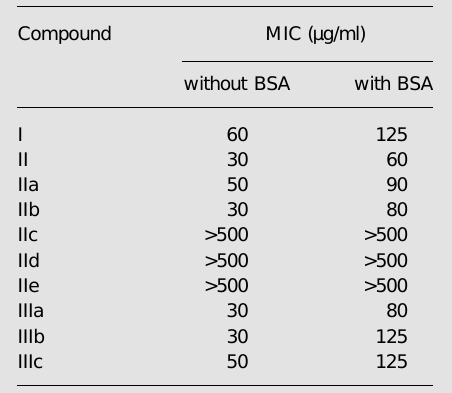
Figure 2. Dose-response effect of 5-amino-8-hydroxy-1,4-naphtho- quinone (compound II) against Staphylococcus aureus (circles), S. epidermidis (squares), and S. intermedius (triangles). The mi- croorganism suspension con- taining 10 6 CFU/ml was added to sterile tubes containing com- pound II to obtain the indicated final concentrations. CFU were determined for each tube after 24-h incubation at 37 º